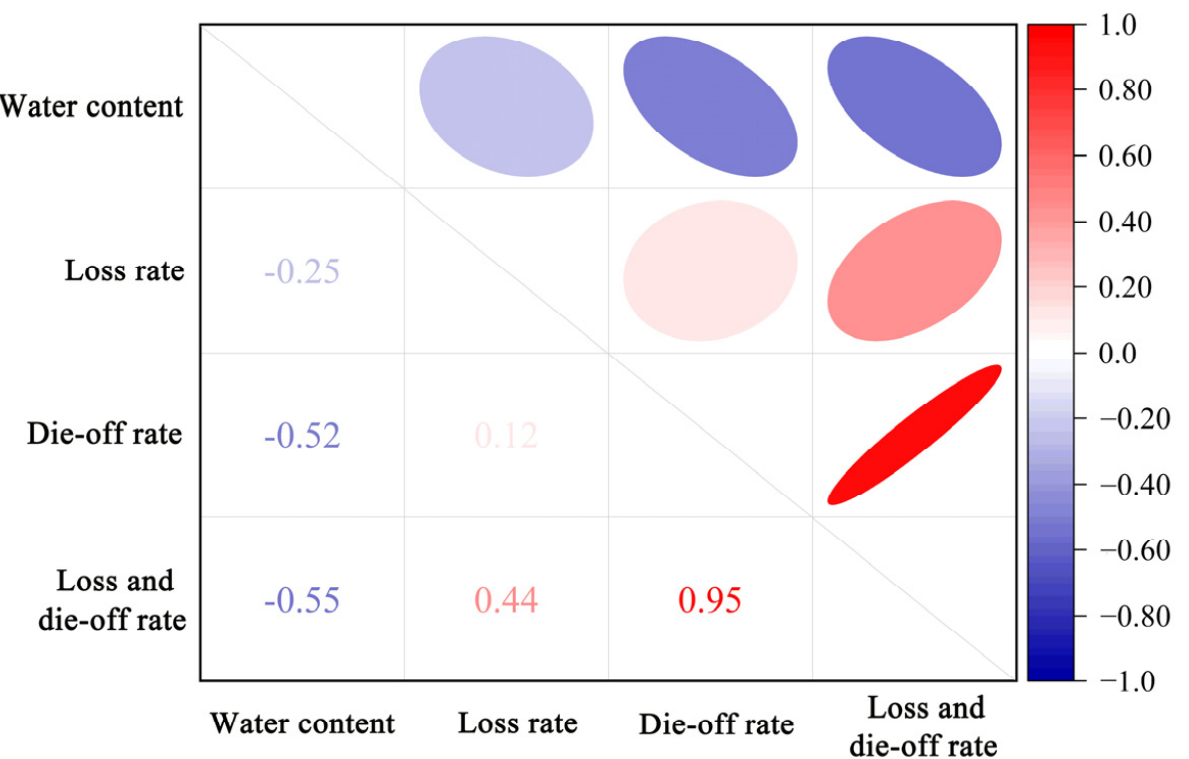
Figure 7. Correlation between LWC, rate of leaf loss, rate of leaf die-off, and their interaction.